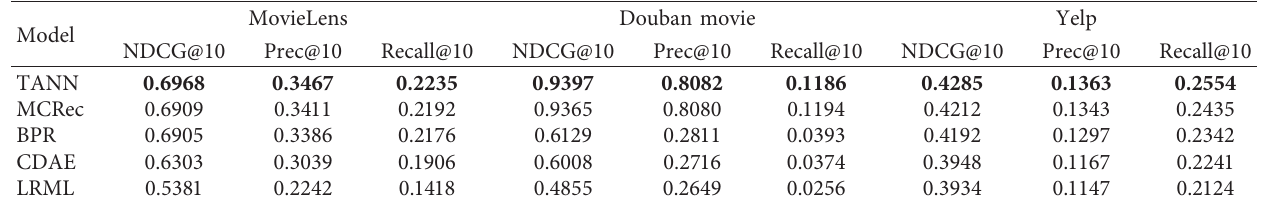
Table 4: Comparison with other recommendation approaches on the three datasets.